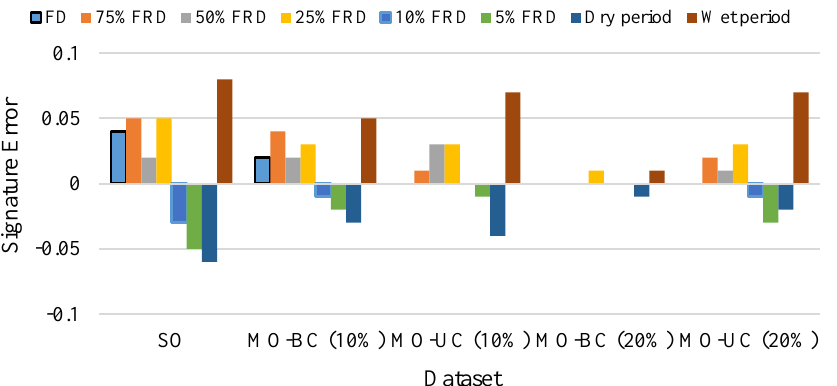
Figure 13. I BF errors based on observations and simulations of five datasets using two main calibra- tion approaches (SO & 4 algorithms parameterization of MO-SB).